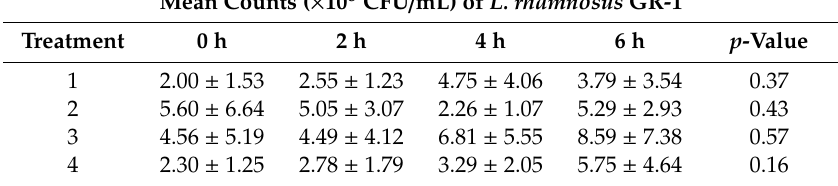
Table 1. Viable counts (Mean ± SD) of Lactobacillus rhamnosus GR-1 in probiotic yogurt treatments following 0, 2, 4, and 6 h of